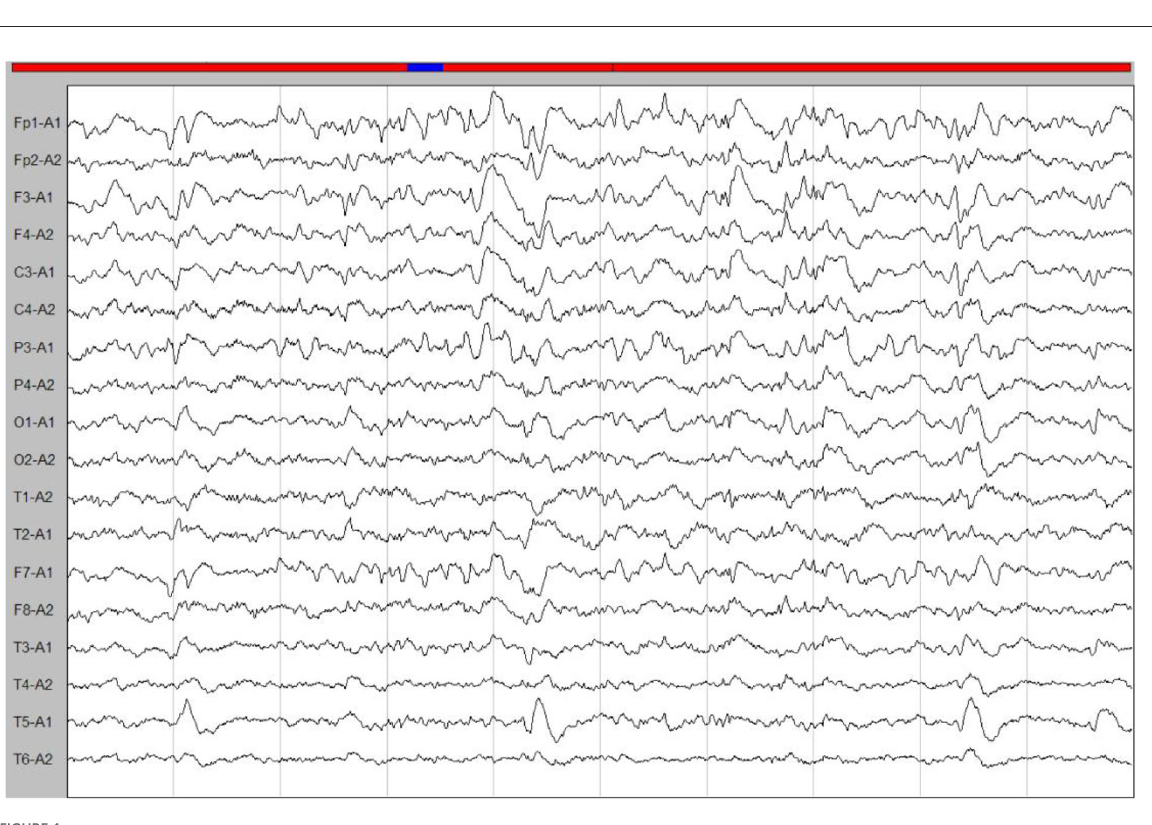
FIGURE4 An ictal EEG. The EEG showed left-sided abnormalities with numerous delta waves, including slow waves mixed with sharp waves, spikes, and wave